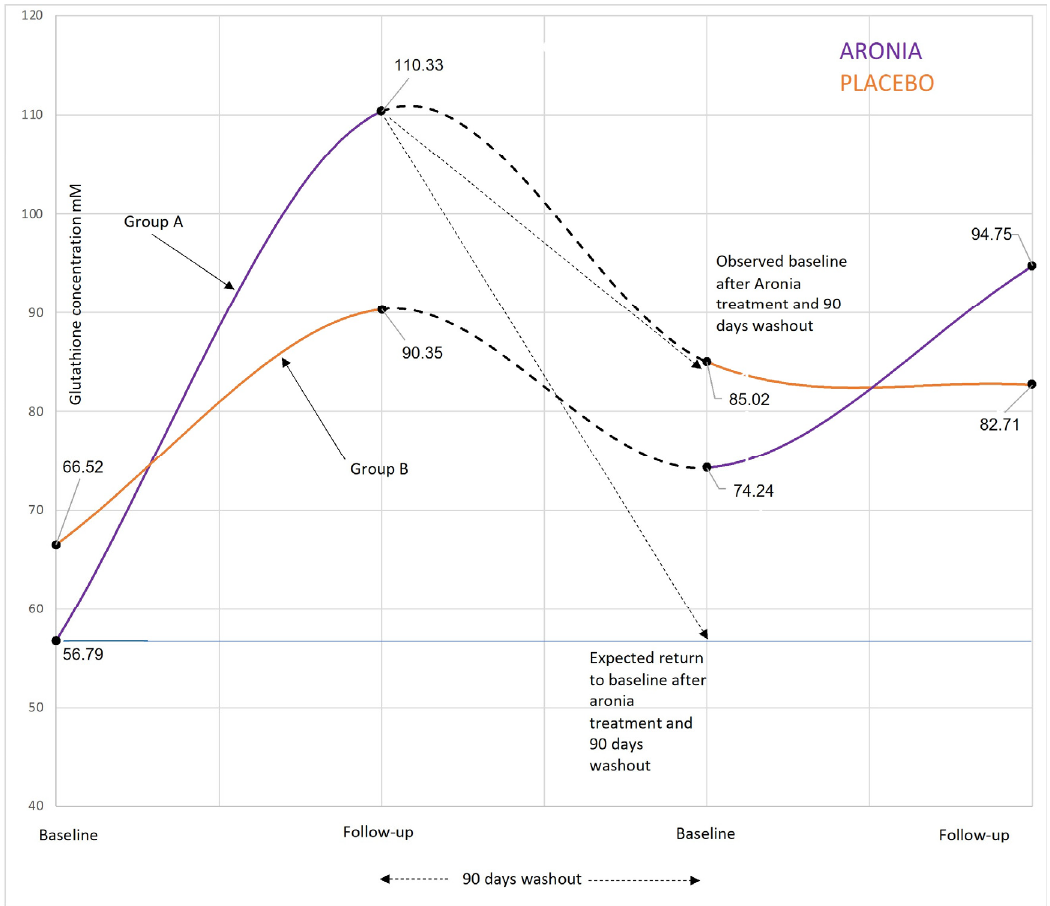
Figure 3. Development in glutathione levels in blood samples following Aronia and placebo supplementation during the 270 days crossover designed. Note the high level of glutathione at follow ‐ up after 90 days of Aronia intake. After the subsequent 90 days wash out, the glutathione baseline would be expected to drop to the level of baseline prior to Aronia supplementation but it only dropped halfway to the original baseline. This indicates a possible long ‐ term effect of Aronia across the washout period. Blue lines indicate periods with 90 days Aronia supplementation, and the orange lines indicate periods with 90 days of placebo administration.